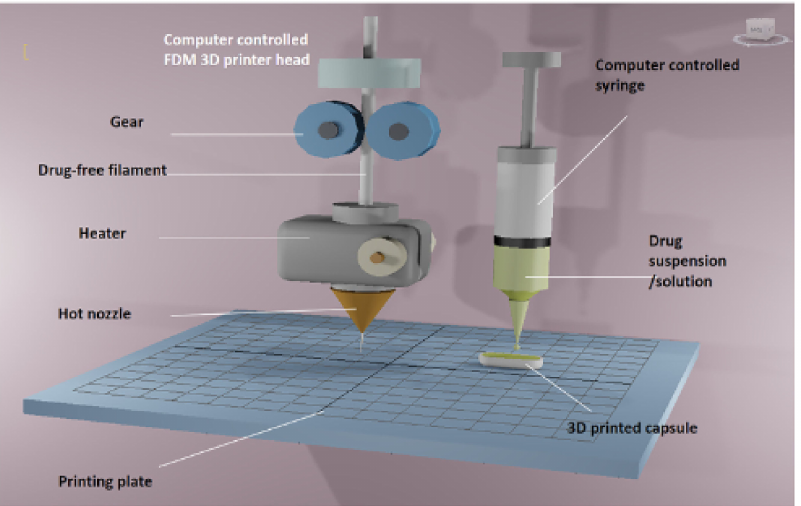
Figure 12. Schematic illustration of the fabrication of 3D-printed liquid capsule. A dual-head 3D printer was modified by replacing the right-hand nozzle with a syringe dispenser. The FDM nozzle head was loaded with HME processed API-free filament of immediate or extended-release properties whilst drug solution or suspension were dispensed using syringes of variable sizes and nozzle diameters. Images reproduced with permission from [114]. Copyright Elsevier,